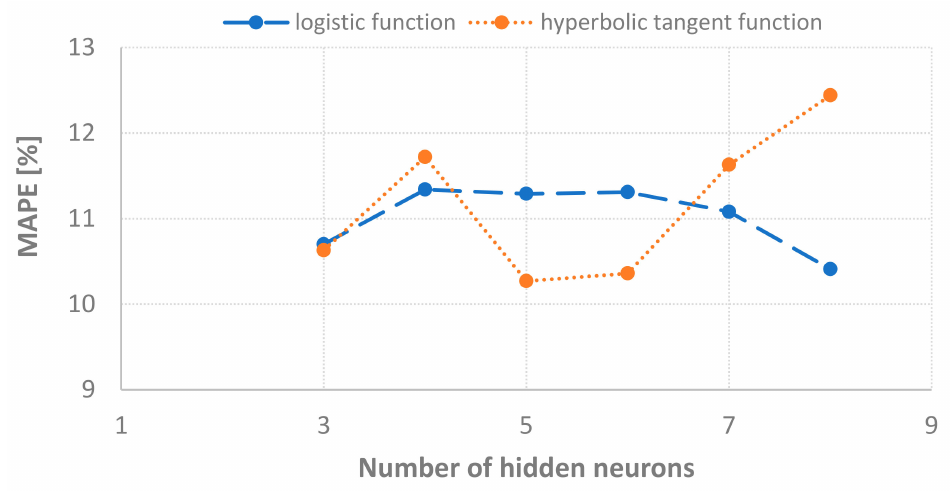
Figure 2. Selection of neural network parameters for prediction of the maximum methane seam pressure, based on the mean prediction error of the neural model.